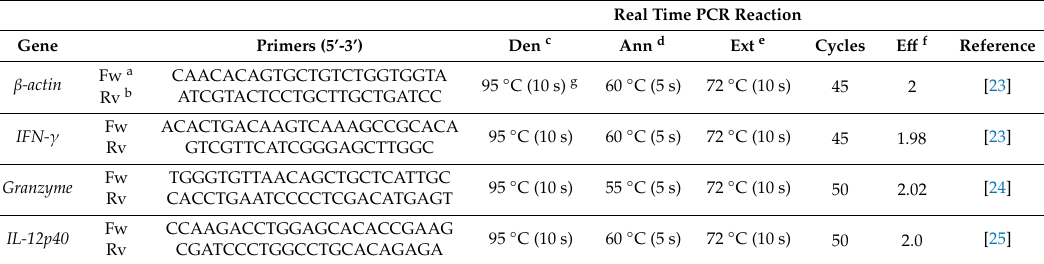
Table 1. List of primers and the reaction conditions used for quantitation of host genes expression by real-time PCR.